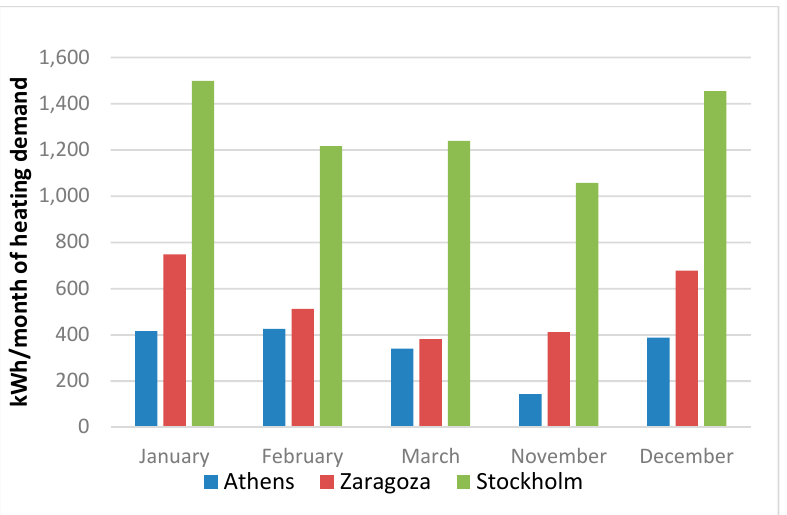
Figure 10. Heating demand (kWh per month) for a type-A dwelling in three different European climates.